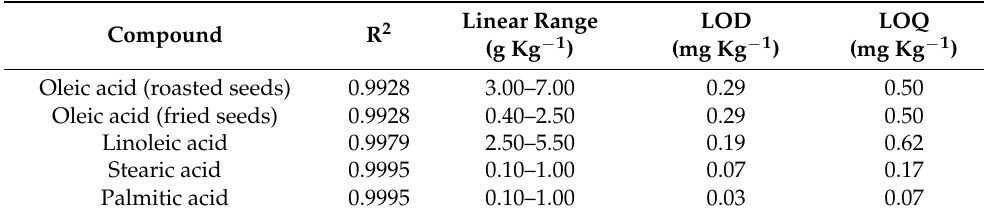
Table 1. Analytical figures of merit for fatty acids determination by GC-MS in sunflower seed